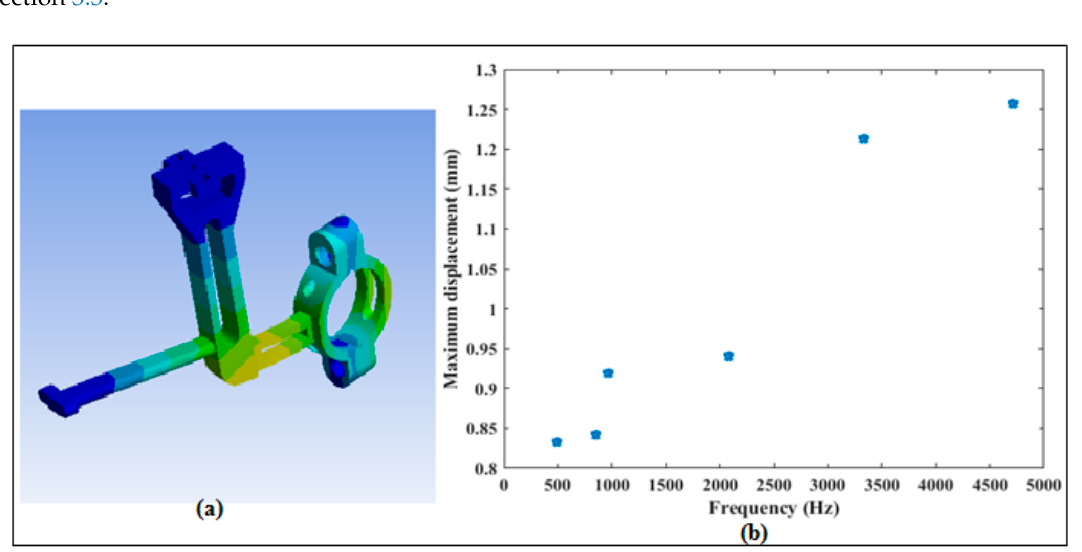
Figure 9. ( a ) FE model of the sensor fixture. ( b ) Frequencies of vibration versus displacements of the sensor holding fixture.